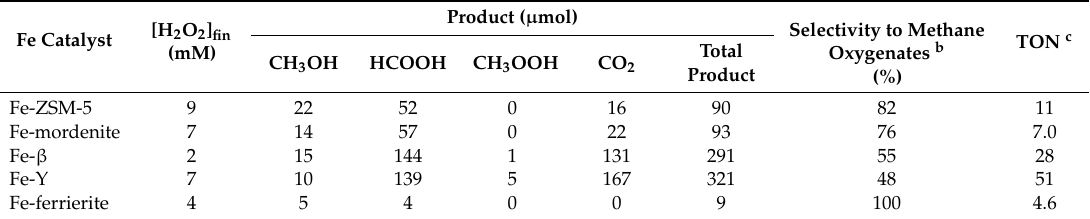
Table 1. Catalytic activity of various Fe-zeolites and 1 wt. % Pd / AC for partial oxidation of methane with H 2 and O 2 .